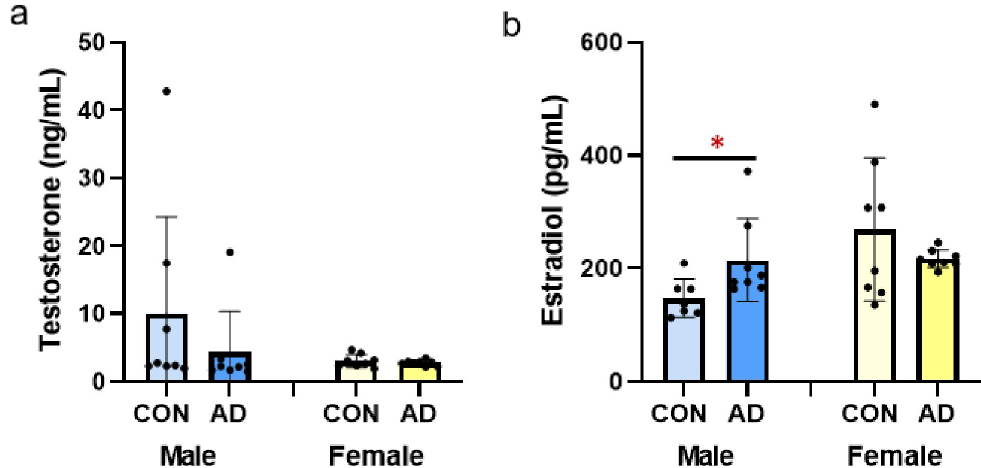
Fig 2. Sex steroids in male and female control and adenine mice. A) Serum testosterone was not different due to adenine in either male or female mice. B) Serum estradiol was higher in male adenine mice vs. control male mice. Estradiol was not different between control and adenine female mice. � Indicates statistical difference (p < 0.05) from t-test between control and adenine within each sex.